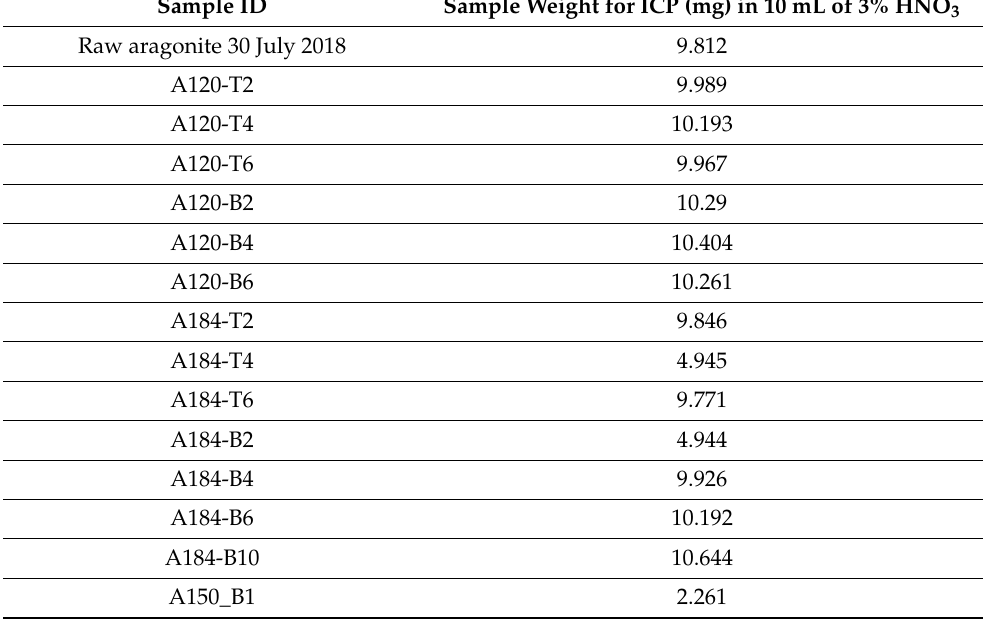
Table A1. Solid preparation for ICP_OES.